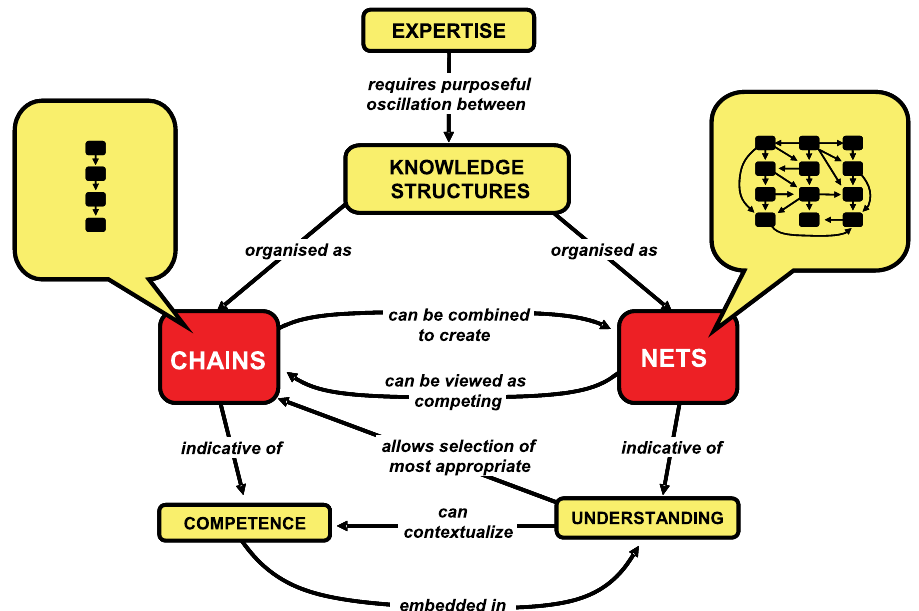
Figure 3. A dual-processing knowledge structures perspective on the nature of